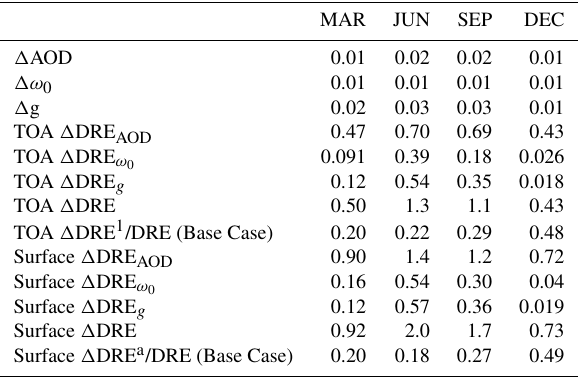
Table 6. Calculated uncertainties in DRE at the TOA and at the surface due to diurnal aerosol variability, using the sensitivities and correlations given in Table 3 and estimates of aerosol diurnal vari- ability as inputs to Eq. (8). Units of (cid:49) DRE are Wm − 2 . Uncertain- ties due to diurnal variability in surface albedo are not included in the